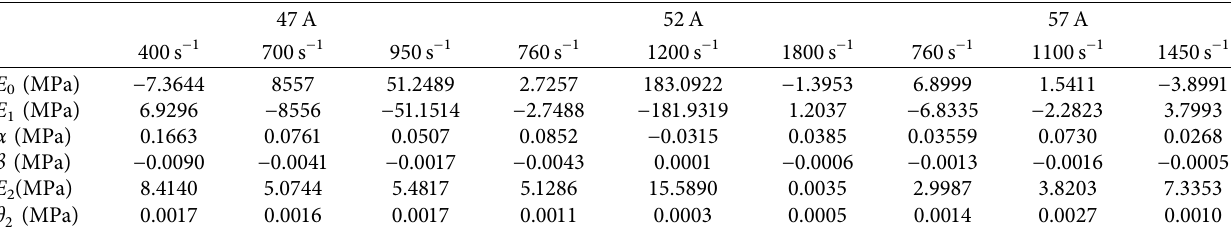
Figure 11: ZWT model sketch. Table 2: Parameters of the dynamic tensile strain curve fitted using the ZWT